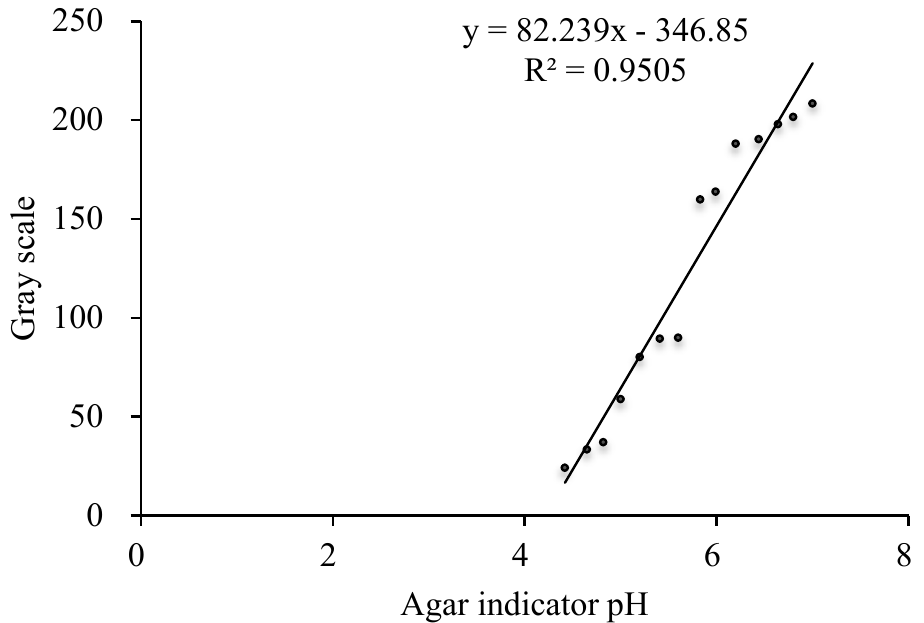
Figure 7. Calibration curve between the gray level and pH, linear calibration was obtained between pH 4.42 and 7.00 (maize). Table 5. Effects of colonization by Ce on the rhizosphere pH and amount of protons secreted by maize under arsenic stress.